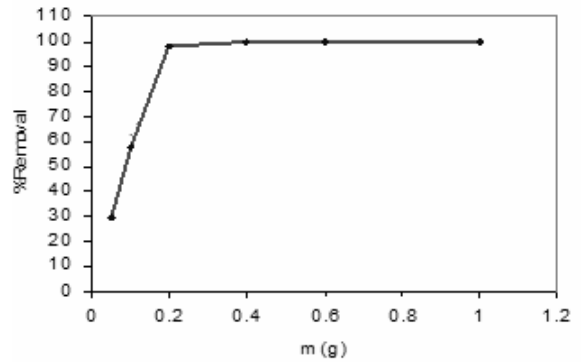
Figure 4. The effect of sorbent dosage on Hg 2+ sorption